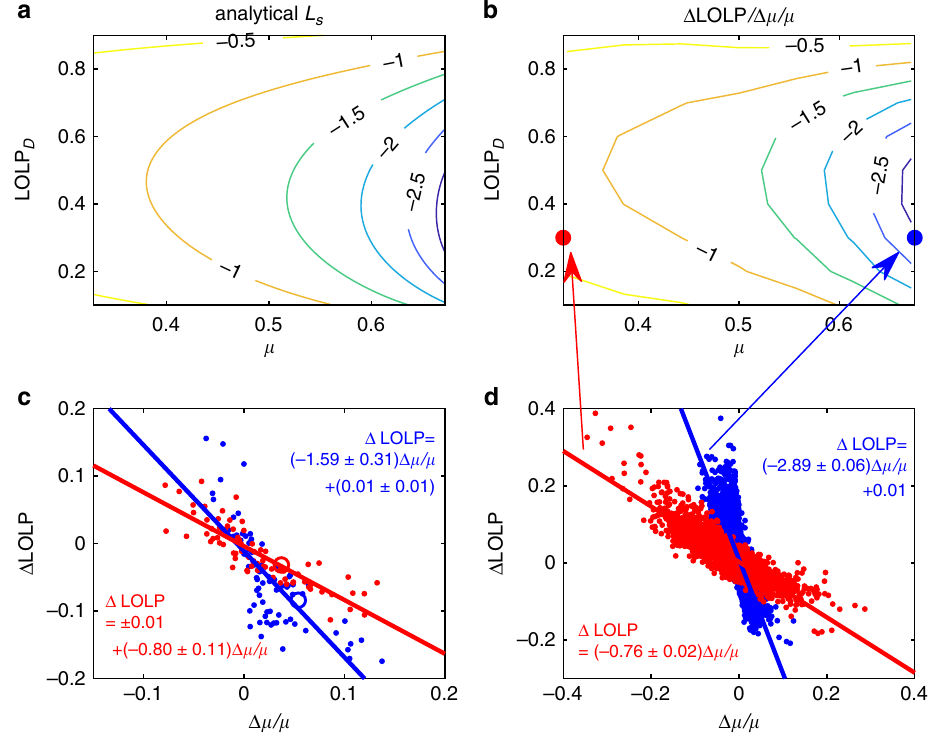
Fig. 4 Sensitivity of loss-of-load probability ( L s ). Contour plots of L s is calculated ( a ) analytically from Eq. (2) and ( b ) numerically from climate model outputs. The red and blue dots in ( b ) are corresponding to the examples in ( d ), which compares the change of loss-of-load probability (LOLP) and the change of mean clearness index ( μ ) from 2006 – 2015 to 2041 – 2050 in January with design LOLP of 0.3 in regions where 0.3 < μ < 0.35 (red dots) and 0.65 < μ < 0.7 (blue dots) as projected by climate models. The red and blue lines are the corresponding best fi t lines and their slopes (i.e., Δ LOLP / ( Δ μ / μ )) numerically represent L s . ( c ) As in ( d ) but only for Bulgaria, Cyprus, Greece, Hungary, and Romania (i.e., region 7 de fi ned in ref. 18 ) in January (red dots) and July (blue dots). The red and blue circles correspond to the example of Southern Romania in Fig. 1. Source data are provided as a Source Data fi